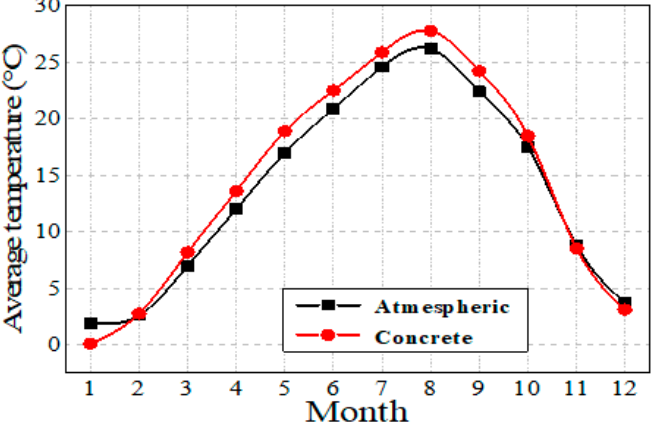
Figure 10. Comparison between atmospheric temperature and concrete temperature.